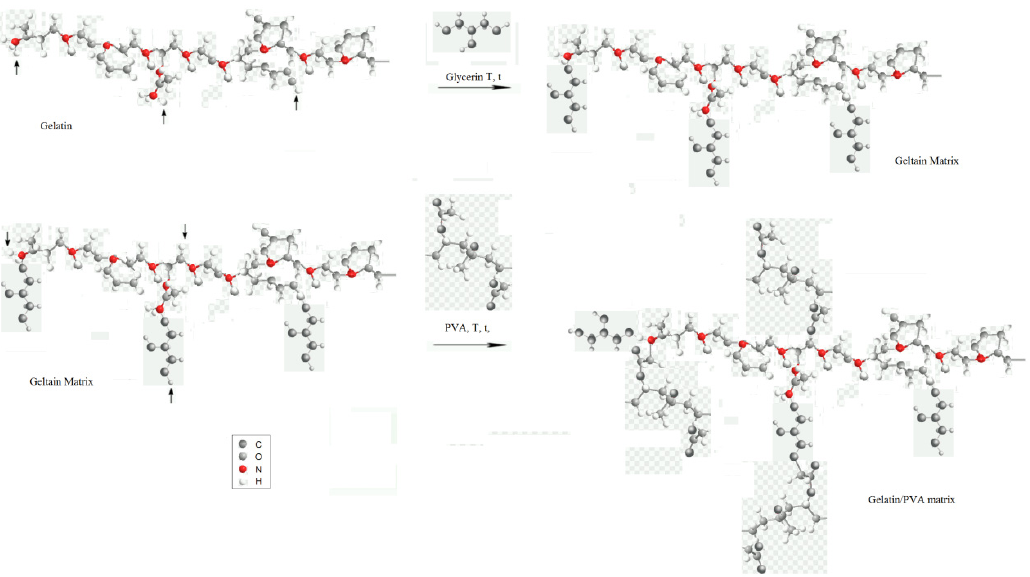
Figure 6. Probable mechanism of interaction of gelatin, PVA, and glycerin macromolecules, leading to the formation of a stable gelatin/PVA matrix.